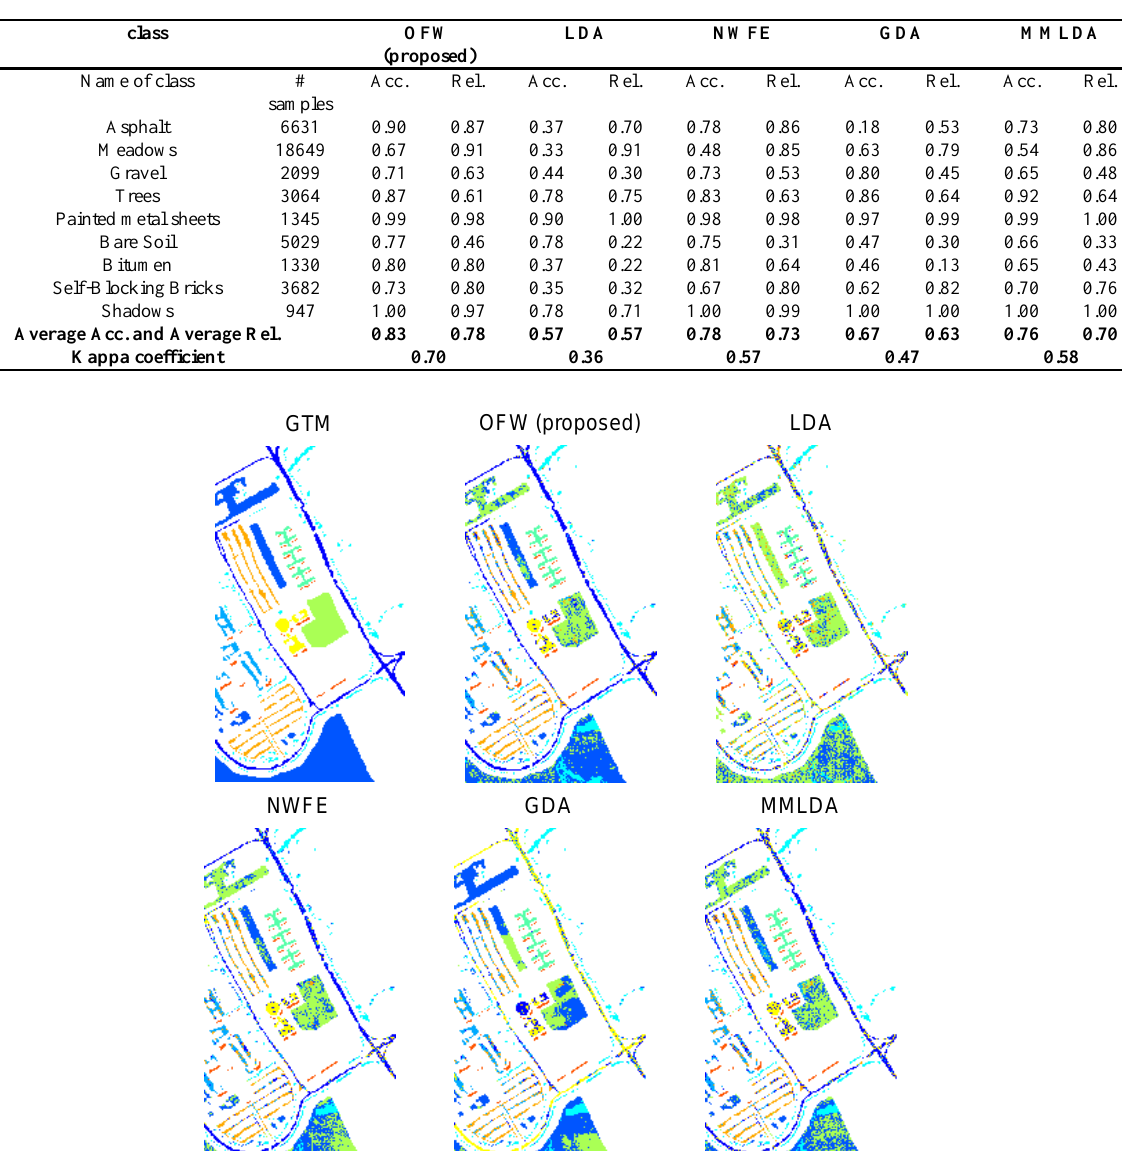
Table 2. Accuracy and reliability of classes of Pavia dataset obtained by SVM classifier and 8 extracted features.